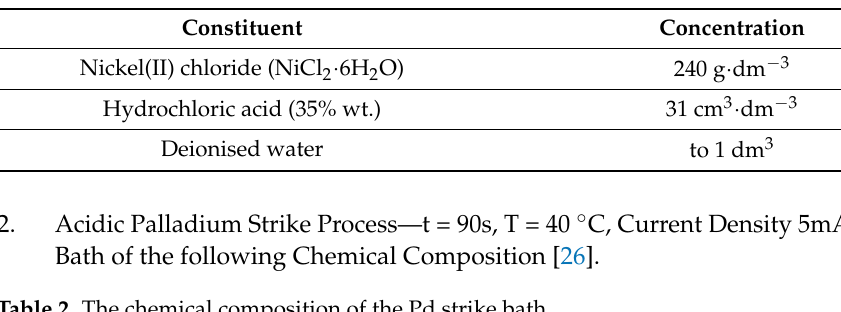
Table 2. The chemical composition of the Pd strike bath.